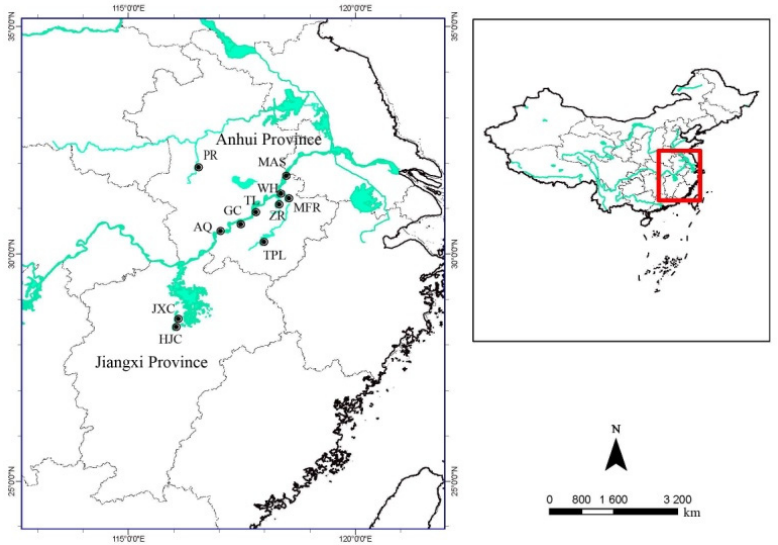
Figure 1. Study sites of Polygonum criopolitanum ( ● : Population. JXC = Jinxian County; HJC = Huangjiacun; TPL = Taiping Lake; MFR = Mafeng River; ZR = Zhang River; AQ = Anqing; GC = GuiChi; TL = Tongling; WH = Wuhu; MAS = Maanshan; PR =Pi River).